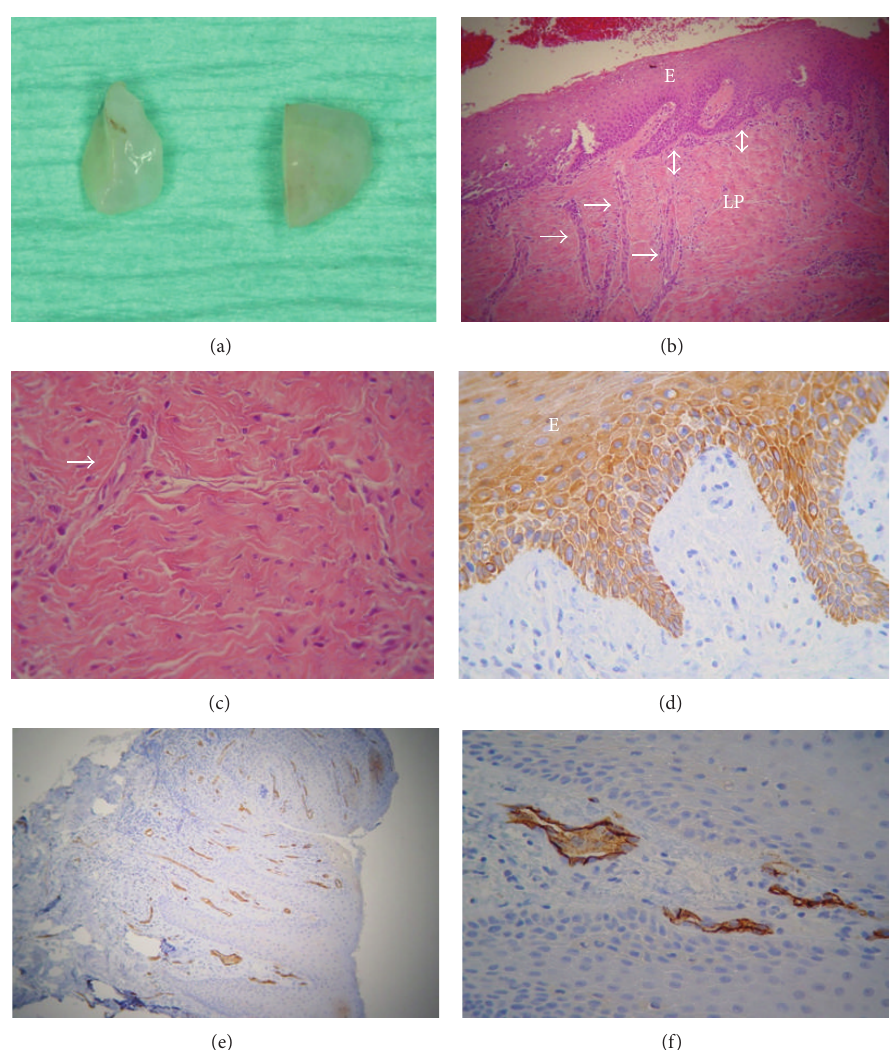
Figure 9: (a–c) Case 1, (d) Case 2, and (e, f) Case 3. (a) Gross tissue specimens. (b–f) Photomicrographs. (b) Normal-appearing oral mucosa, covered by parakeratinized squamous epithelium (E) with long interconnecting rete pegs (double arrows) and medium-sized vessels (arrows) (hematoxylin and eosin stain, original magnification × 200). (c) Lamina propria (LP) composed of fibrous connective tissue. Notice the many fibroblasts (purple nuclei) and a capillary vessel (arrow) (hematoxylin and eosin stain, original magnification × 400). (d) Pan- keratin-positive parakeratinized squamous epithelium (E) (streptavidin-biotin-peroxidase immunohistochemistry, original magnification × 200). (e, f) Normally distributed CD34-positive capillary vessels (brown) (streptavidin-biotin-peroxidase immunohistochemistry, original magnification (e) × 100, (f) ×